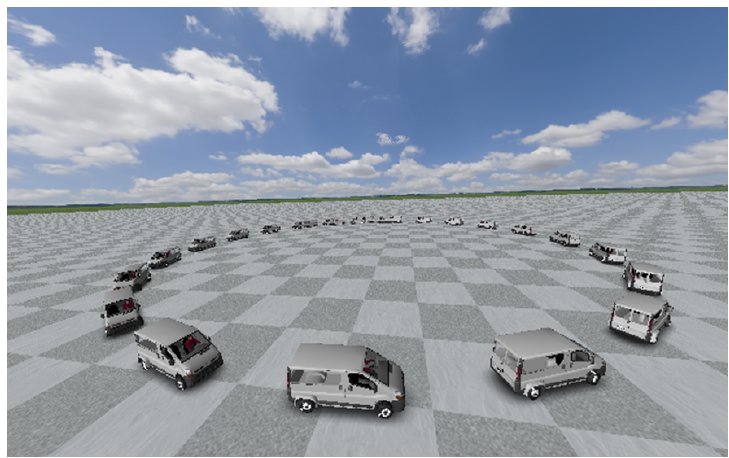
Figure 8. Simulated scenario por a Left J-turn maneuver in Trucksim R (cid:13)